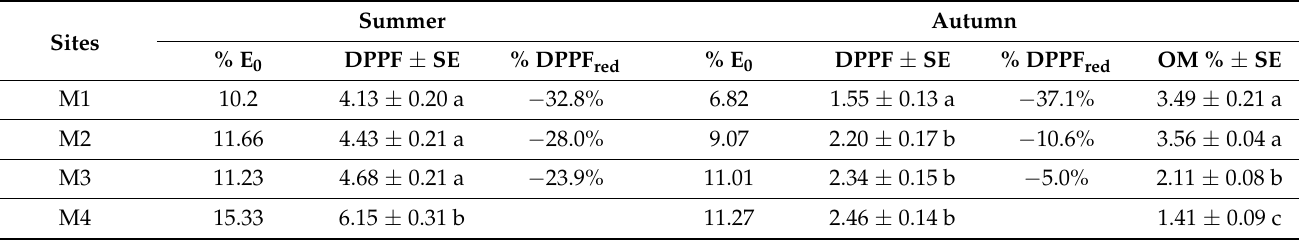
Table 1. Mean values of abiotic factors measured at the four studied sites (M1–M4) in summer and autumn: daily photosynthetic photon flux (DPPF, mol quanta m − 2 d − 1 ), the percentage of subsurface irradiance (% E 0 ), the reduction in available irradiance relative to the reference station M4 (% DPFF red ) and sediment organic matter content (% OM; only in autumn). Letters a–c